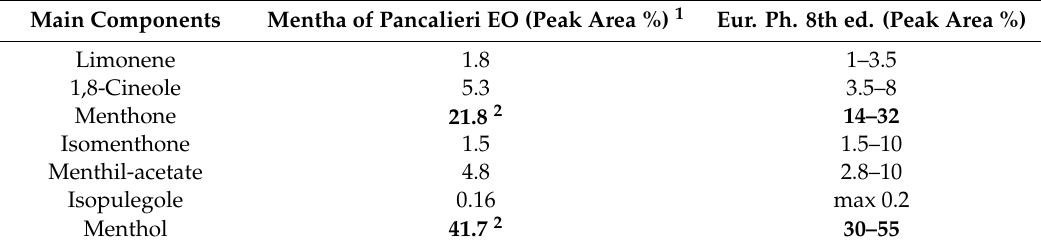
Table 1. Phytochemical composition of “Mentha of Pancalieri” essential oil (EO) in comparison with the European Pharmacopeia indications for Mentha x piperita (Lamiaceae) essential